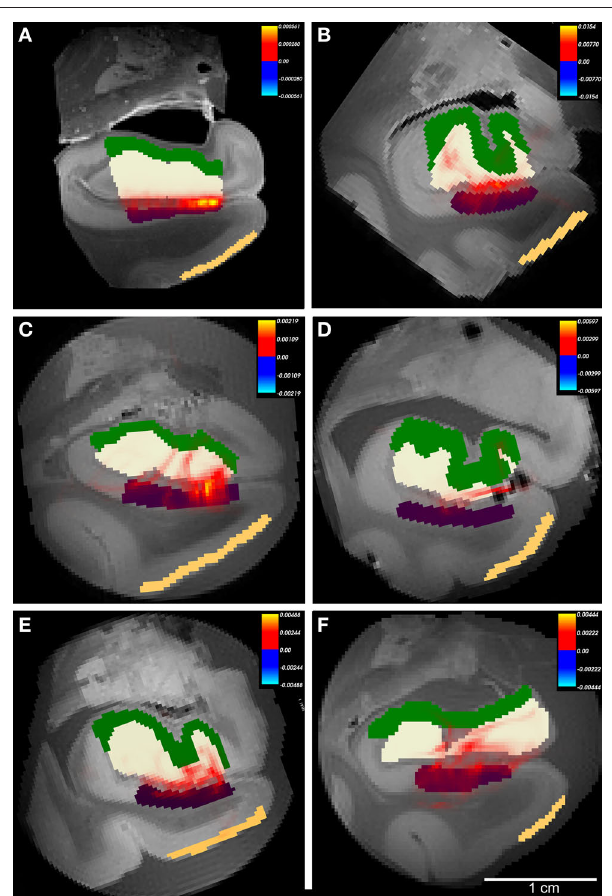
Figure 8 | The probabilistic tractography results between labeled region subicular cortices (subiculum+presubiculum) and dentate gyrus for all cases. In this illustration, probability for entorhinal cortex layer II was not tested and label is shown for reference only. Color labels represent entorhinal layer II (beige), subiculum (purple), dentate gyrus (white) and hippocampus (green). Case A had gadolinium treatment prior to MR scanning and exhibits less noise. All cases showed connections with non-zero probability (A–F) , but cases with higher FA generated higher values than cases with lower FA. Panels (A–F) represent cases 1-6, respectively with Table 1. Heatmap scalebar located in upper right corner for all